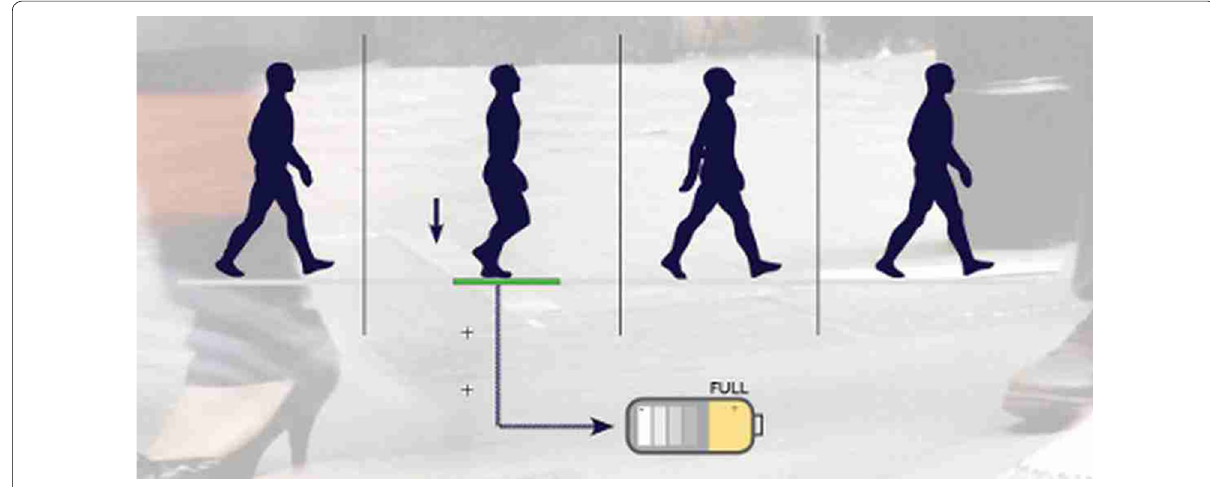
Fig. 2 Kinetic energy systems positioned on the ground (from http://www.paveg en.com)